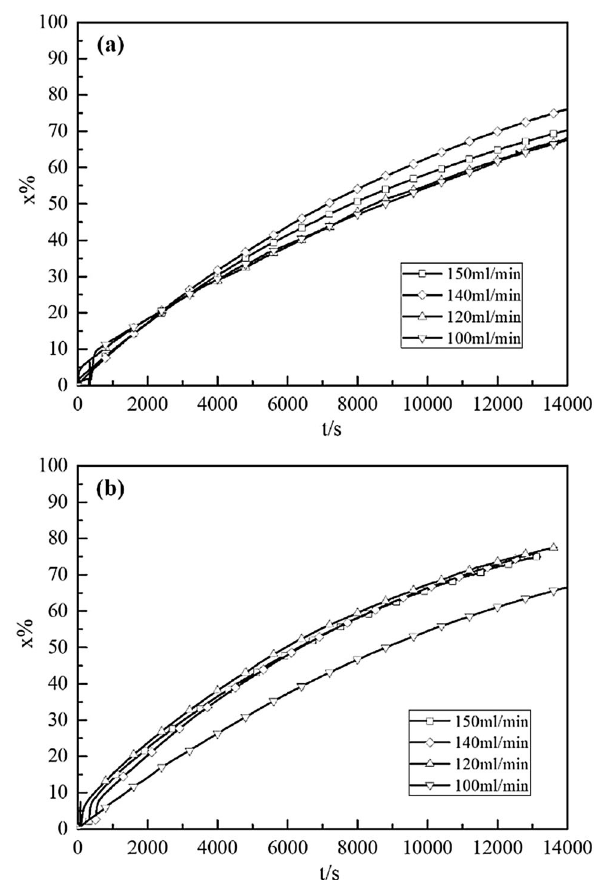
Fig. 2 Variation of carbon conversion with time at different gas flow rate in a raw coke samples and b samples adsorbed Na 2 CO